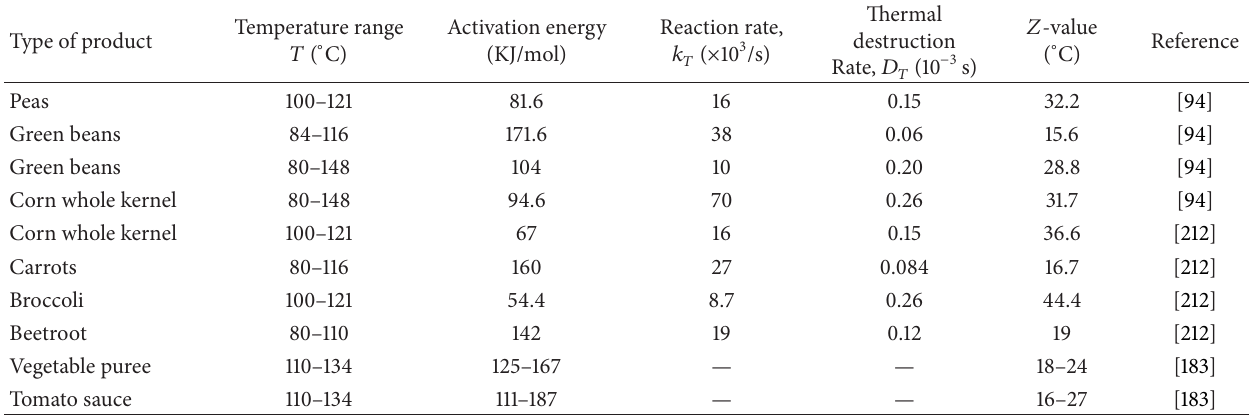
Table 4: Kinetic factors affecting overall sensory quality of thermally processed vegetables.